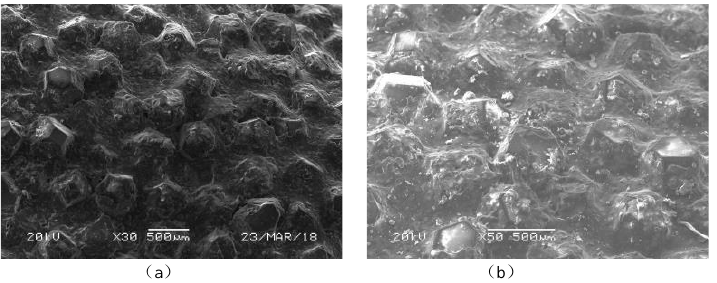
Figure 2. Surface topography of brazed diamond beads: ( a ) before the cutting, ( b ) after the cutting. Periodic extrusion and friction result in fatigue cracks and abrasive wear on the one hand, yet, on the other hand, subtly changed the positions of the diamond grits, thus avoiding complete abrasion. Figure 3 shows the abrasive wear and position change of a single diamond grit during cutting. The protrusion heights of the brazed diamond beads are higher than those of the sintered ones. Additionally, the bonds between the diamond grits and the matrix of beads are so strong that the dropping of grits is rare. Therefore, a brazed diamond wire saw is an ideal choice for X56 steel pipeline cutting.